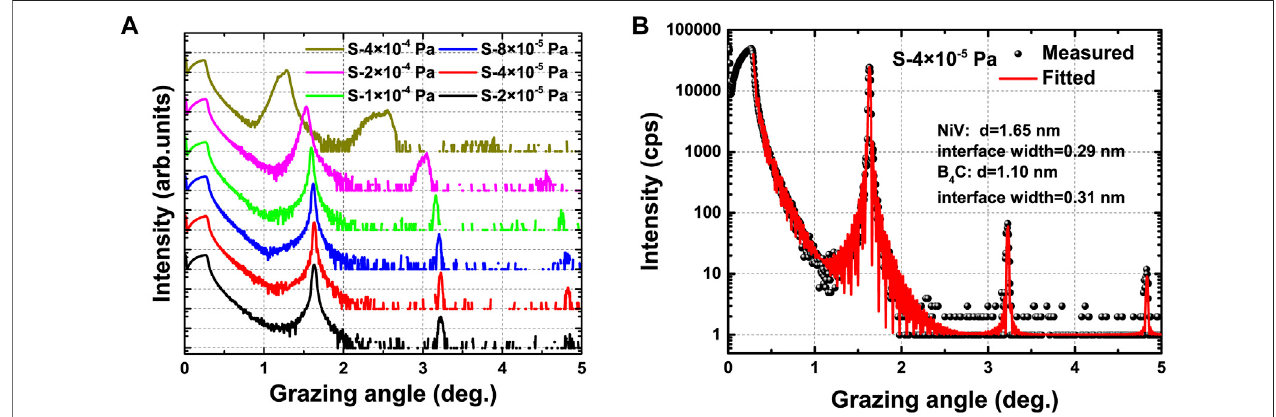
FIGURE 1 | (A) Grazing incidence x-ray re fl ectivity (GIXR) measurement of NiV/B 4 C multilayer deposited with different background pressures. (B) GIXR measurement and fi tted result of NiV/B 4 C multilayer deposited with a background pressure of 4 × 10 − 5